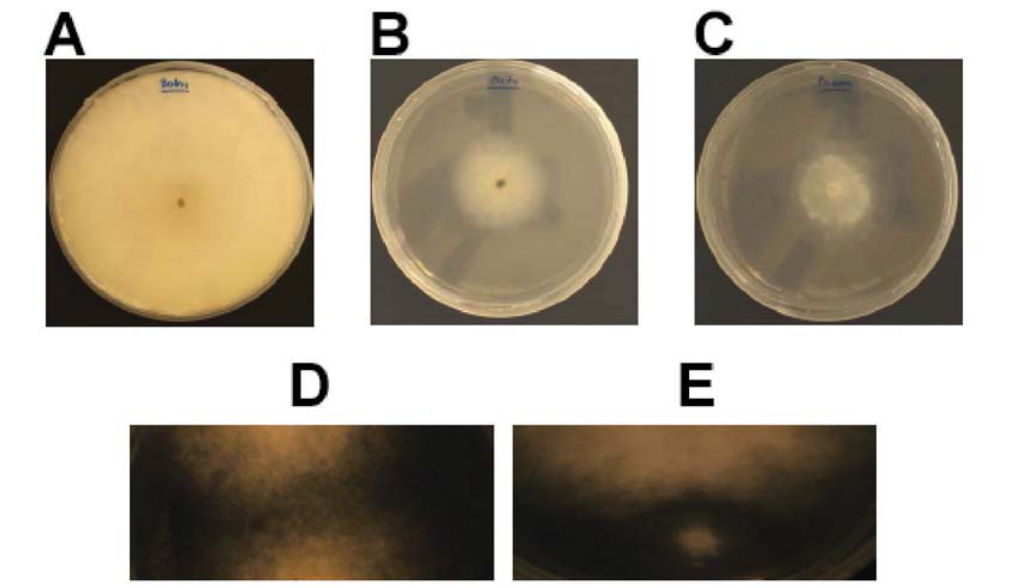
Fig. 2. Fungal growth for 5 days. (A) Botryosphaeria parva ; (B) Eutypa lata ; (C) Phomopsis viticola ; and detailed view of the interface between B. parva - B. parva (D) or B. parva - E. lata colonies (E). Due to the lower growth rate of E. lata , the centre of its colony is visible in 2E.